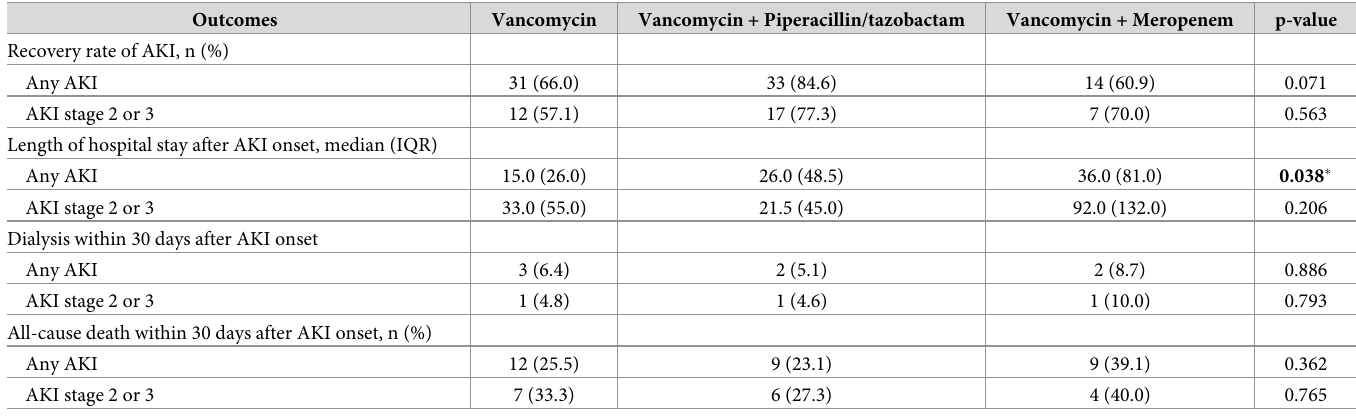
Table 3. Evaluation of clinical outcomes according to treatment